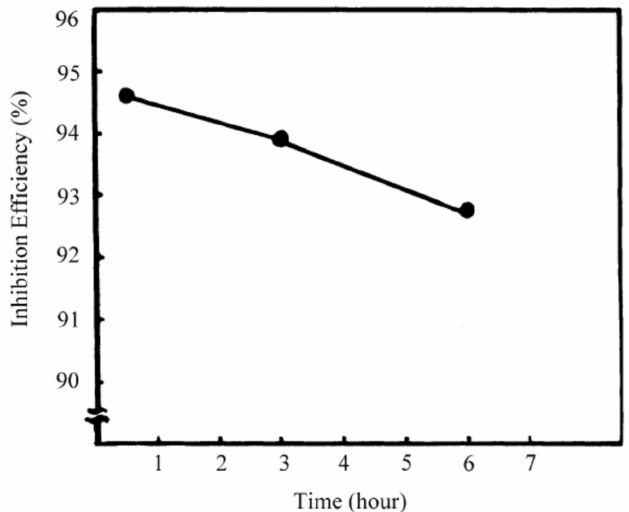
Figure 3. Variation of inhibition efficiency with immersion time of UMOD for N-80 steel in 15% boiling HCl from weight loss measurements [70].